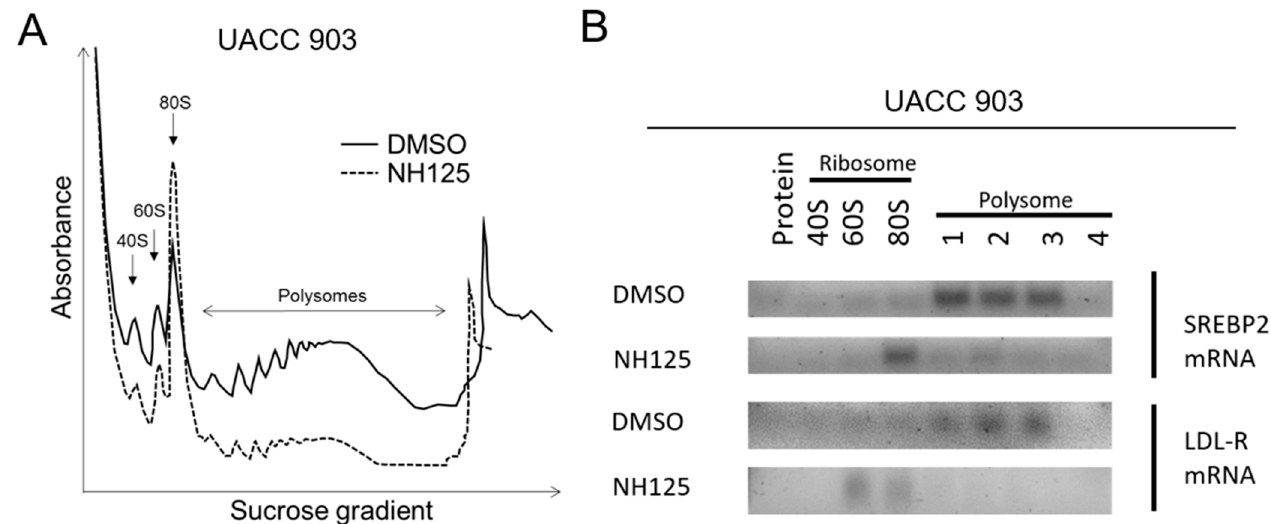
Figure 5. NH125 decreased the translation of SREBP2 and LDLR. Cell lysates were subjected to sucrose density gradient centrifugation to collect the ribosomal and polysomal fractions; RNA was extracted from pooled fractions; and analysed by PCR for SREBP2 as well as LDL-R mRNA abundance. The primers were designed using the Primer-BLAST software on the NCBI website. 5 µM NH125 reduced the polysomal fraction of UACC 903 cells after 24 hours of treatment with a concomitant increase in the 80S ribosomal fraction compared to DMSO treated cells ( A ). mRNAs for SREBP2 and LDLR shifted from the polysomal fraction to the ribosomal fraction after NH125 treatment ( B ). The experiments were replicated thrice and representative images are shown. The gel images were inverted to increase the resolution.